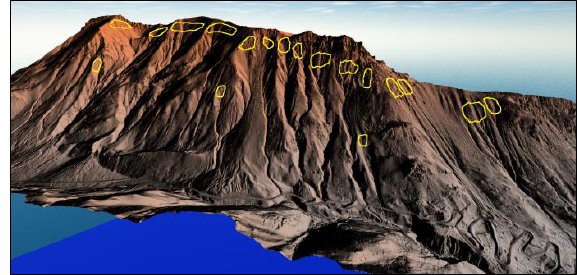
Figure 9. High-resolution tridimensional DTM of the study area obtained with Global Mapper SW, 3D view module. Yellow circles are reference snow avalanches detachment